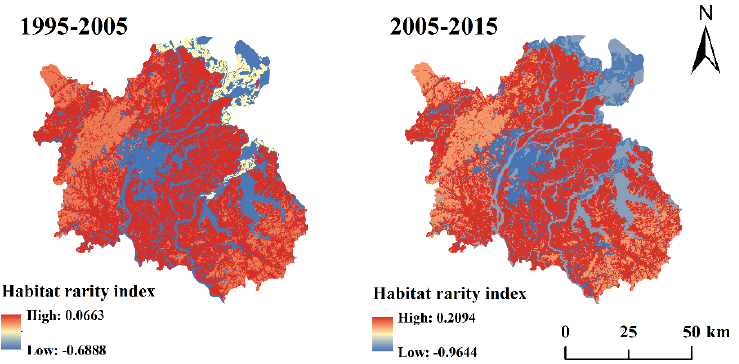
Figure 5. Spatial distribution pattern of the habitat rarity index in 1995–2005 and